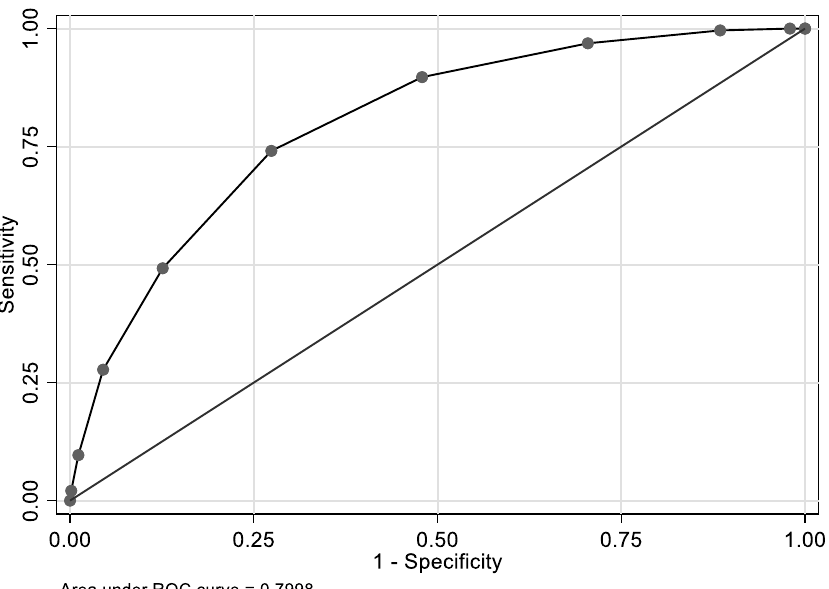
Figure 2. Nine-marker index (Index I) and its predictive value of elevated Hcy: ROC curves for pooled NHANES 1 . 1 n = 13,822; optimal cut-point was at 5; AUC = 0.799, 95% CI: 0.785,0.814. Index I included binary biomarkers of elevated Hcy selected using LASSO and backward elimination. The full list of the nine components of Index I are: Age, serum folate, serum vitamin B-12, serum creatinine, red cell distribution width, mean cell hemoglobin, serum cotinine, serum uric acid and alkaline phosphatase. Cut-points for individual components are: serum folate, Log e , in nmol/L , < 2.83; serum creatinine, Log e , in µmol/L ≥ 4.481; older age, in years, ≥ 49; serum vitamin B-12, Log e , in pmol/L, <5.74; mean cell hemoglobin, Log e , in pg , ≥ 3.422; red cell distribution width, Log e , in %, ≥ 2.553; serum uric acid, Log e , in µmol/L , ≥ 5.826; serum alkaline phosphatase, Log e , in µmol/L , ≥ 4.356 U/L; serum cotinine, Log e , in ng/mL , ≥ -0.579.